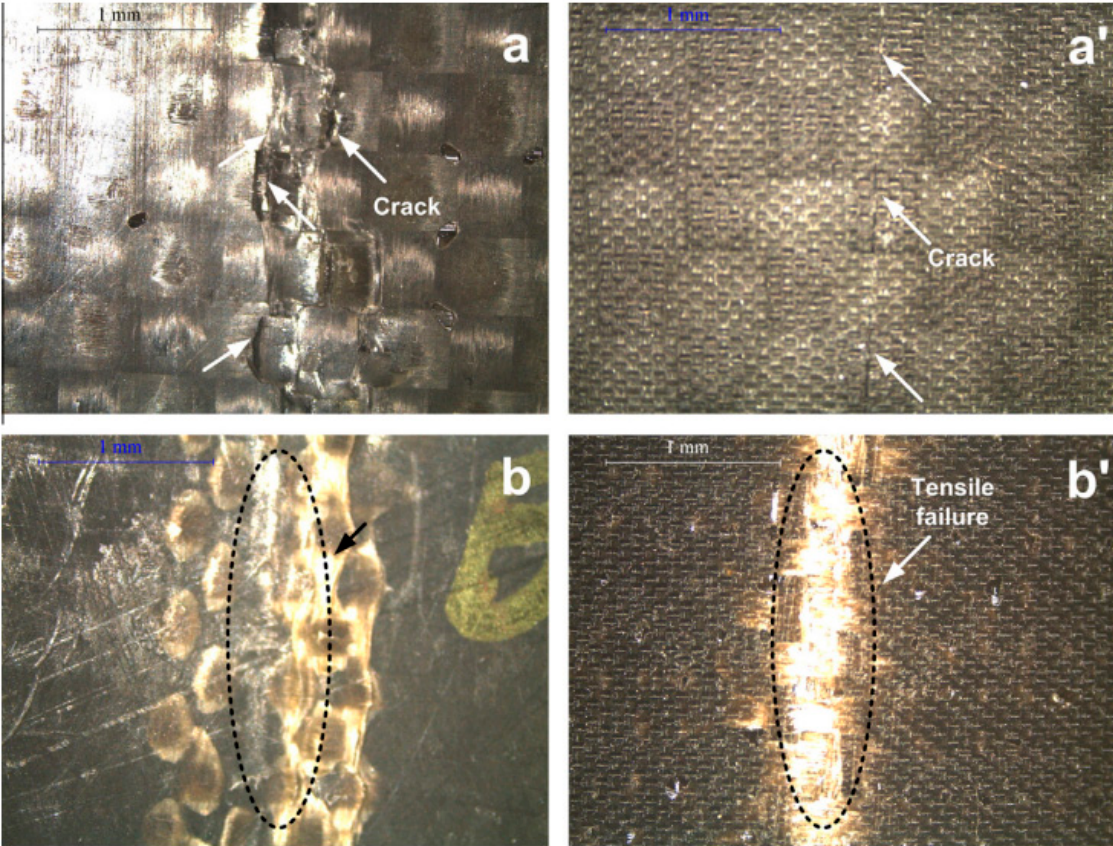
Figure 6. The failure surfaces of hybrid laminates after a flexural test: carbon fabric (( a ) and ( a’ )) and basalt fabric (( b ) and ( b’ )) at the compressive side ( a , b ) and at the tensile side ( a’ , b’ ), respectively (original picture from the author of the chapter). Table 3. The interlaminar shear strength of glass/basalt and carbon/basalt hybrid laminates with respect to the originating laminates [30] (from copy available at www.unitn.it).